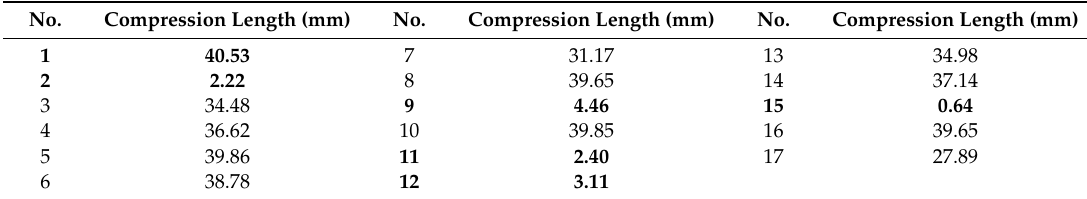
Table 4. Compression lengths of the aluminum